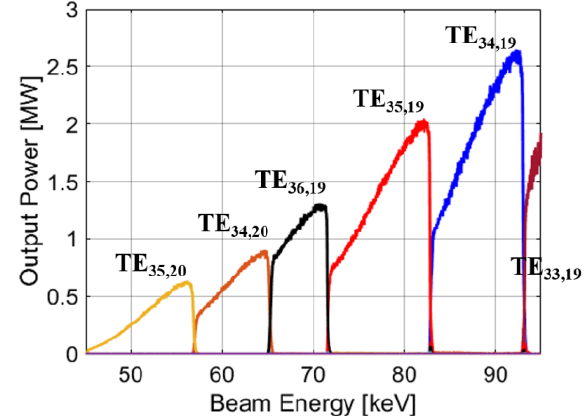
Fig. 5. Realistic start-up scenario with existing coaxial cavity at 6.86 T and I beam = 75 A with non-linear uptaper using the magnetic field profile proposal from the new SC magnet and the gun parameters from the new coaxial MIG.